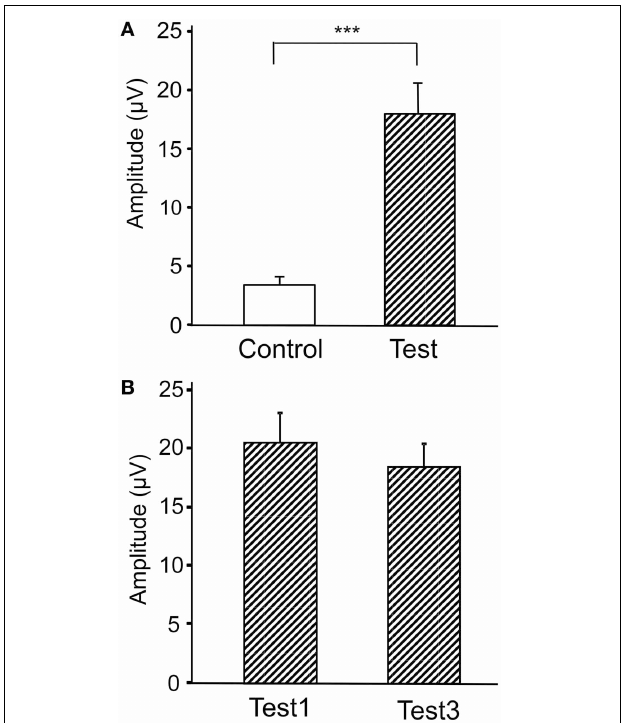
FIGURE 6 | Comparison of the peak amplitudes of the averaged ERPs between the control and test phases (A) and between the first and third trials in the test phase (B). ∗∗∗ p < 0 .